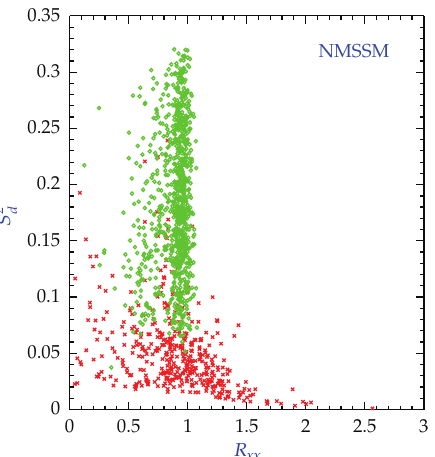
Figure 6: Same as Figure 2, showing the signal rate R γγ versus S 2